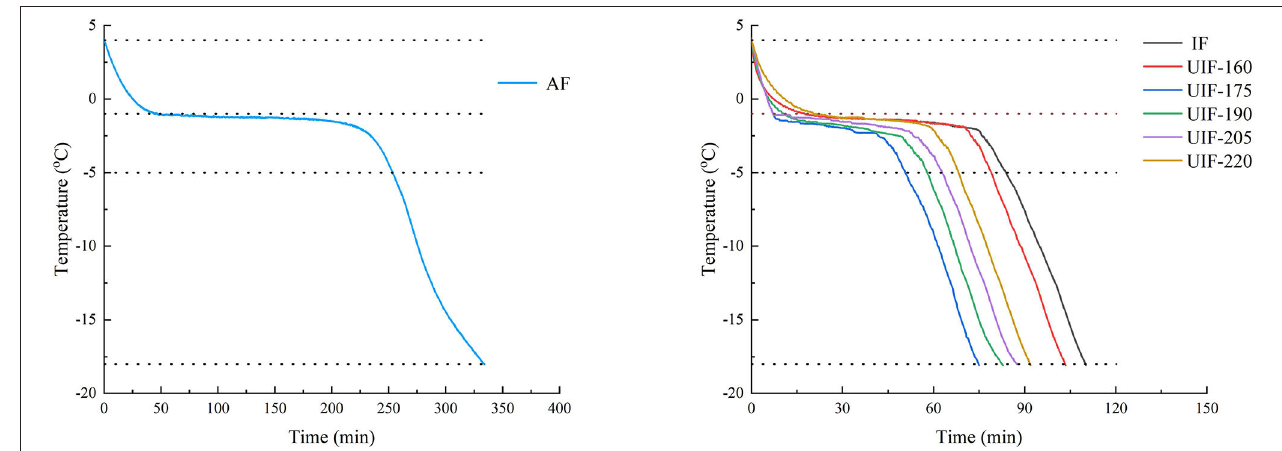
FIGURE 2 | Freezing curves of large yellow croaker with different freezing treatments.